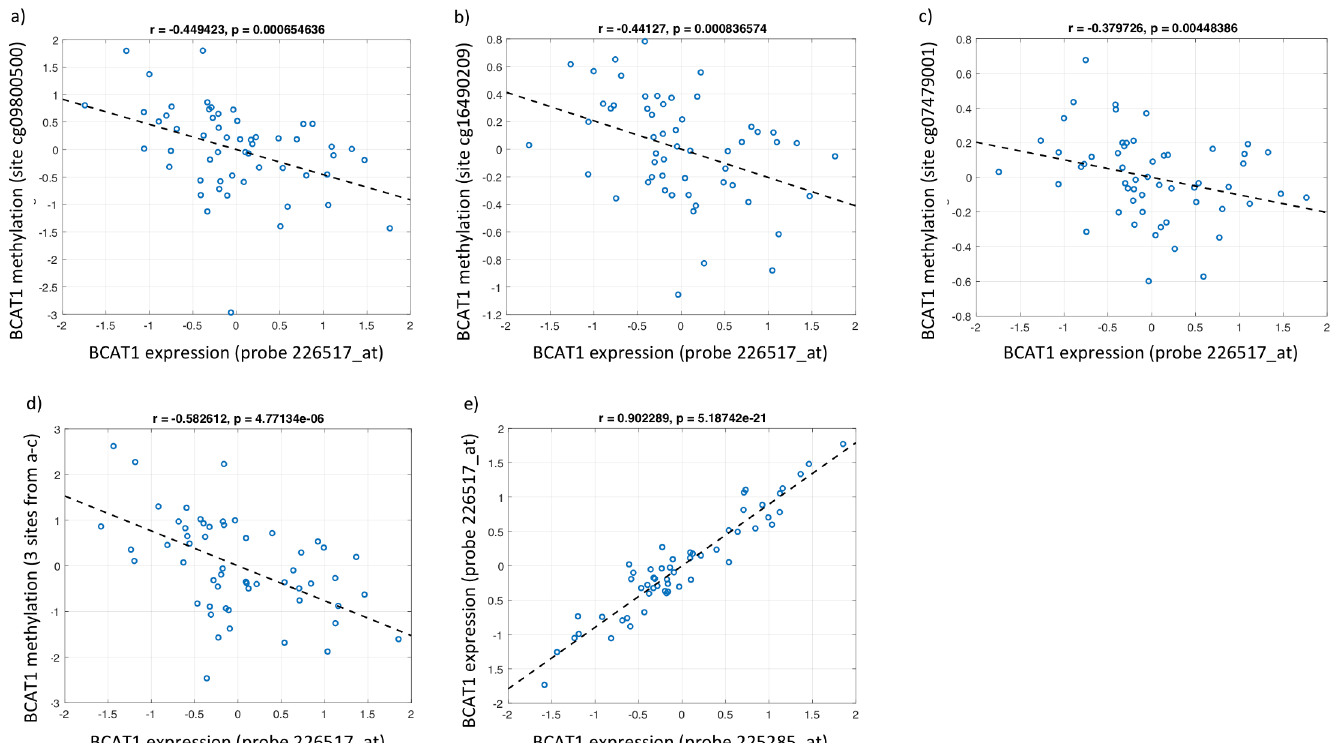
Fig 3. Correlation between BCAT1 gene expression and methylation. 3a)– 3c) show the significant inverse correlation between gene expression for one probe on BCAT1 (226517_at) and methylation at three separate CpG sites on BCAT1 (cg09800500, cg16490209 and cg07479001). Negative correlation is highlighted by the linear fit (dashed line) with corresponding correlation coefficients (r values) and statistical significance. 3d) Correlation between gene expression at the previously mentioned BCAT1 probe (226517_at) and DNA methylation improves when the three signficant CpG sites are combined (summed) for analysis. 3e) Two gene expression probes on BCAT1 (226517_at and 225285_at) are well correlated with one another. For all figures, normalized gene expression and methylation M values are shown. For 3a)- 3c), each point represents a paired gene expression and methylation sample. M values are inversely correlated with gene expression values as